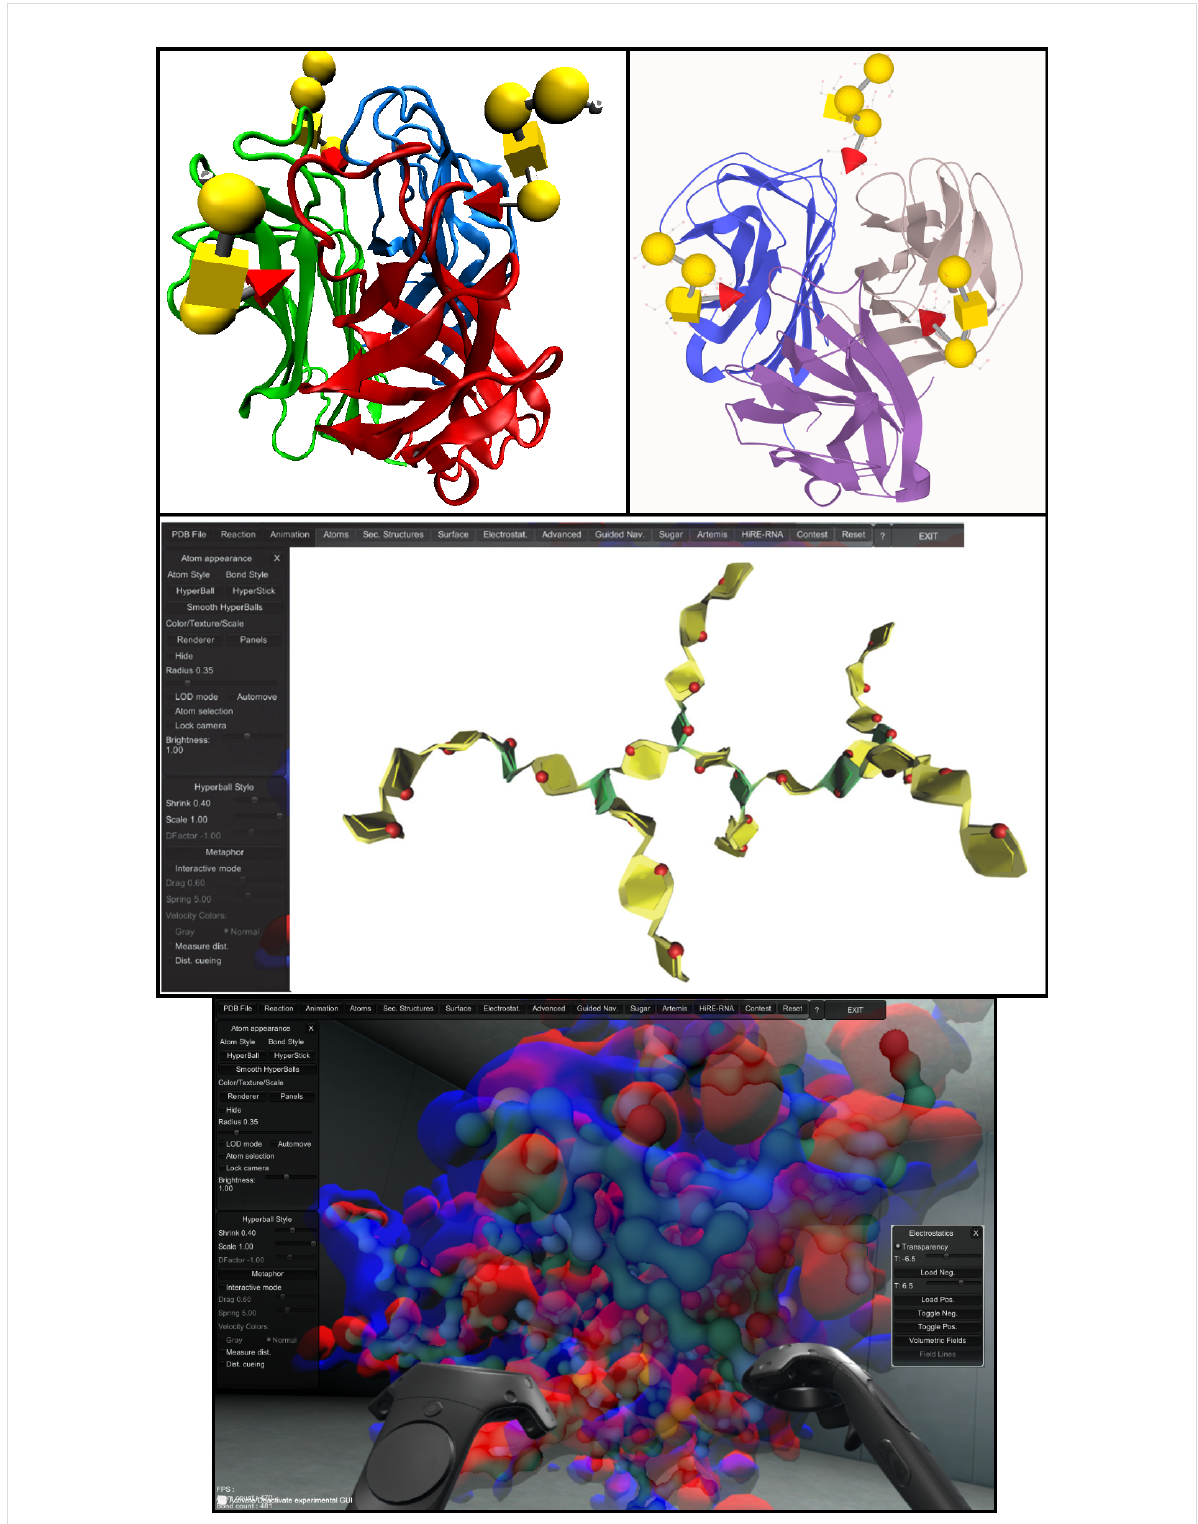
Figure 11: From top to bottom: 3D-SNFG representation of glycan using 3D-SNFG script integrated VMD [79]. LiteMol [80] interface with 3D-SNFG representation of glycan in a protein–glycan complex. SweetUnityMol [81] among the several types of representations a ribbon-like display of polysac- charide ribbons maintains the SNFG colour coding of monosaccharides. UnityMol [82] within an immersive virtual reality